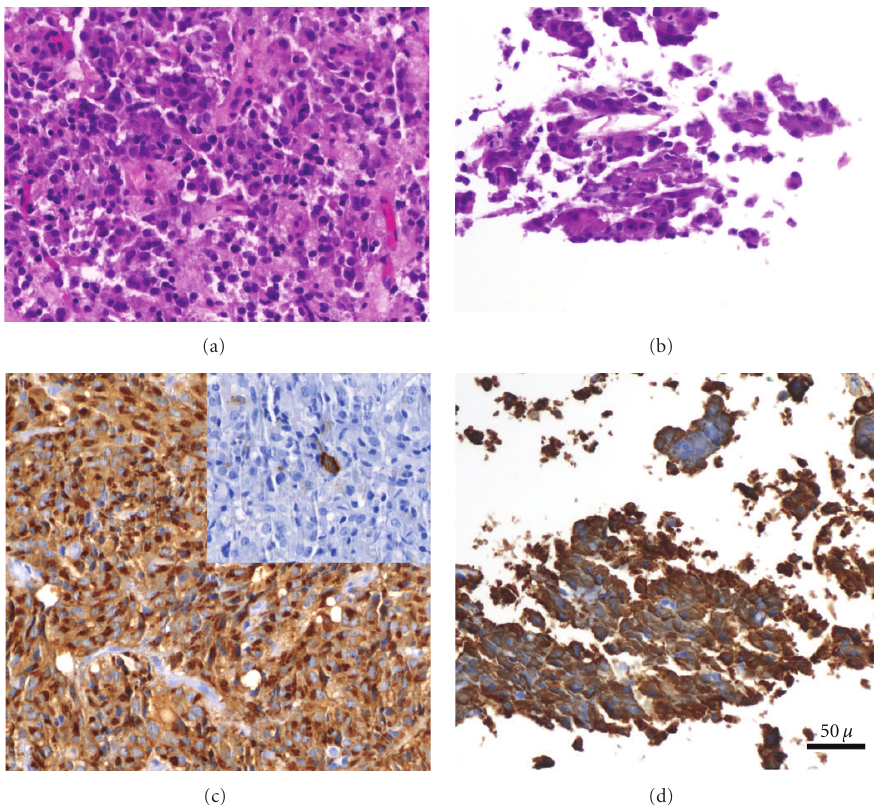
Figure 2: Pathology images of the tumor. (a) H&E stain of the larger tumor tissue showing abundant eosinophilic cytoplasm. (b) H&E stain of the smaller tissue showing abundant basophilic cytoplasm. (c) Immunohistochemistry: all of the cells in the larger adenoma were immunoreactive with antibodies to prolactin, and rare cells (Inset) were growth hormone positive. (d) Immunohistochemistry: cells of the small pieces of adenoma were ACTH